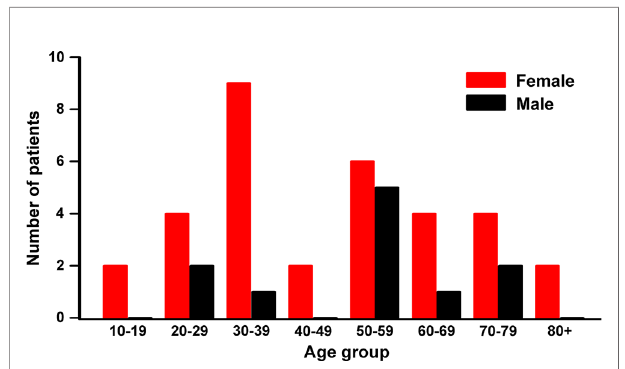
FIGURE 2 | Patient distribution by gender and age groups. High occurrence age is the 50s in both male and female, while the highest in female is the 30s. Nonparametric Kruskal-Wallis ANOVA test showed signi fi cant differences between genders by age group ( p = 0.0136), but not the median age between genders (p